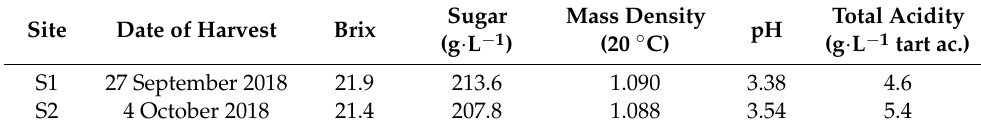
Table 2. Main characteristics of the grape musts at the date of harvest at the two sites under